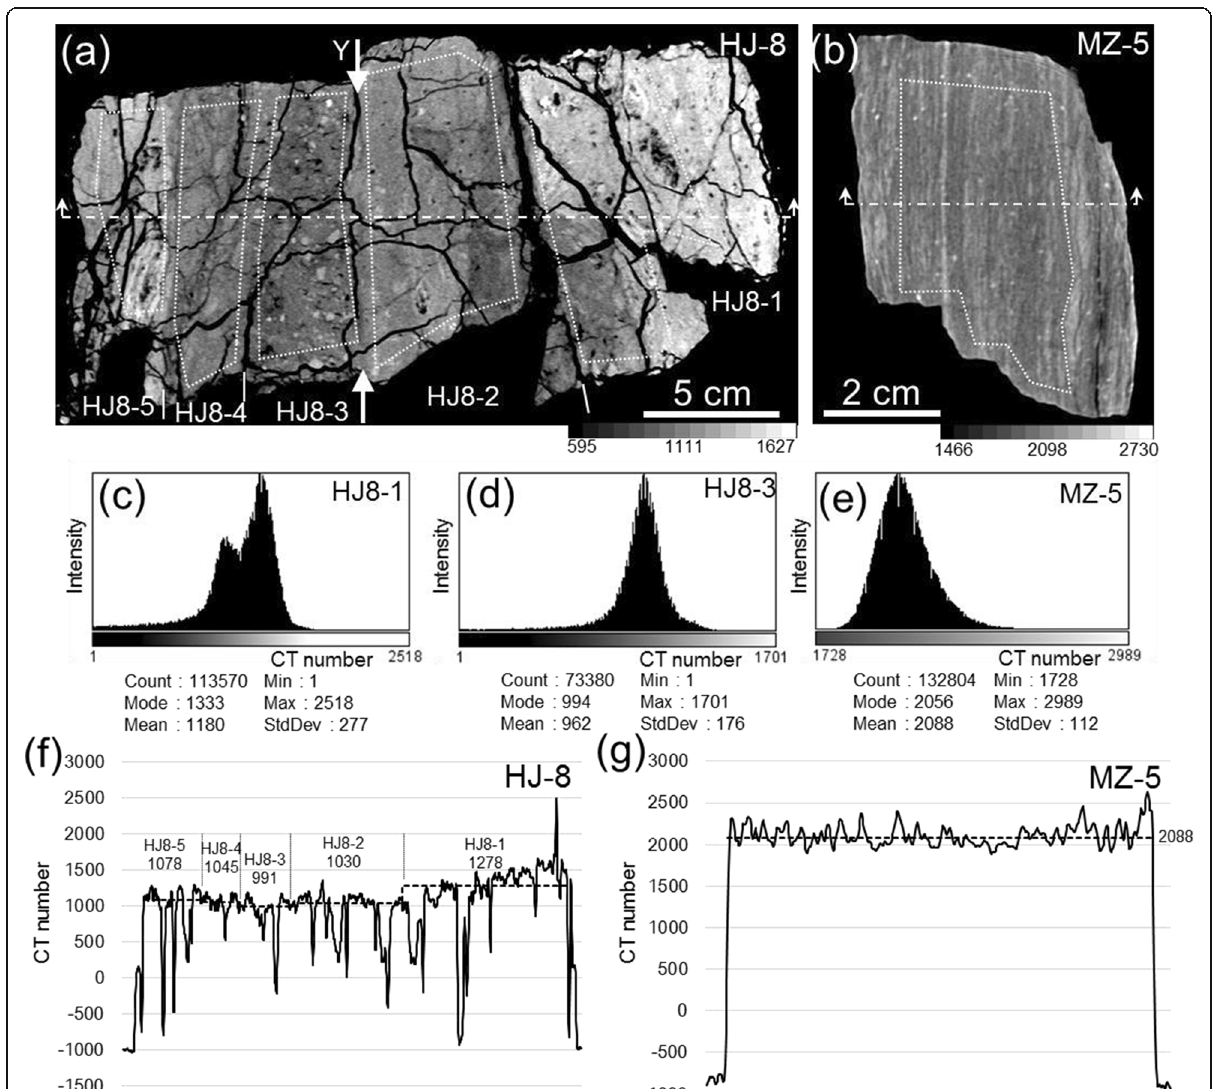
Fig. 6 X-ray CT image analysis results for the Hiji outcrop samples. CT images of samples a HJ-8 and b MZ-5. CT number histograms for c HJ8-1, d HJ8-3, and e MZ-5. The modal CT number, N CTM , for each zone was calculated near the center (within the white dotted line), with the peripheral CT numbers excluded. CT number profiles for f HJ-8 and g MZ-5, with the values calculated along the dash – dotted lines in ( a ) and ( b ),